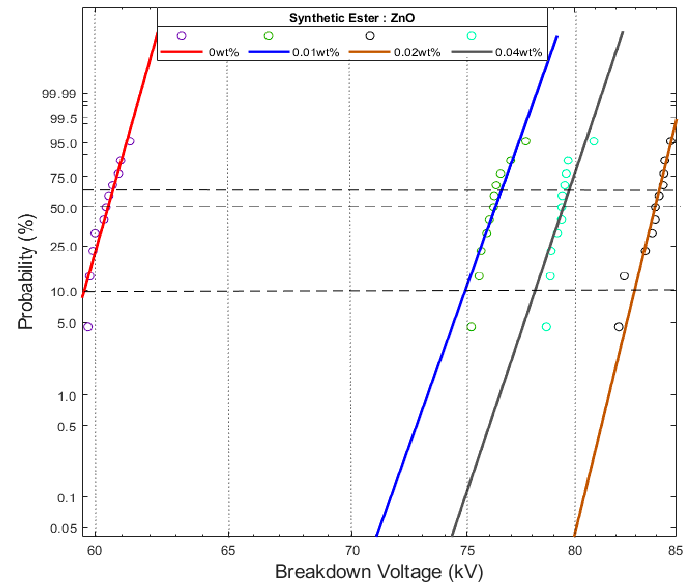
Figure 9. Plot of Probability distribution Vs. Breakdown voltage for ZnO nanofluids and Pure oil .